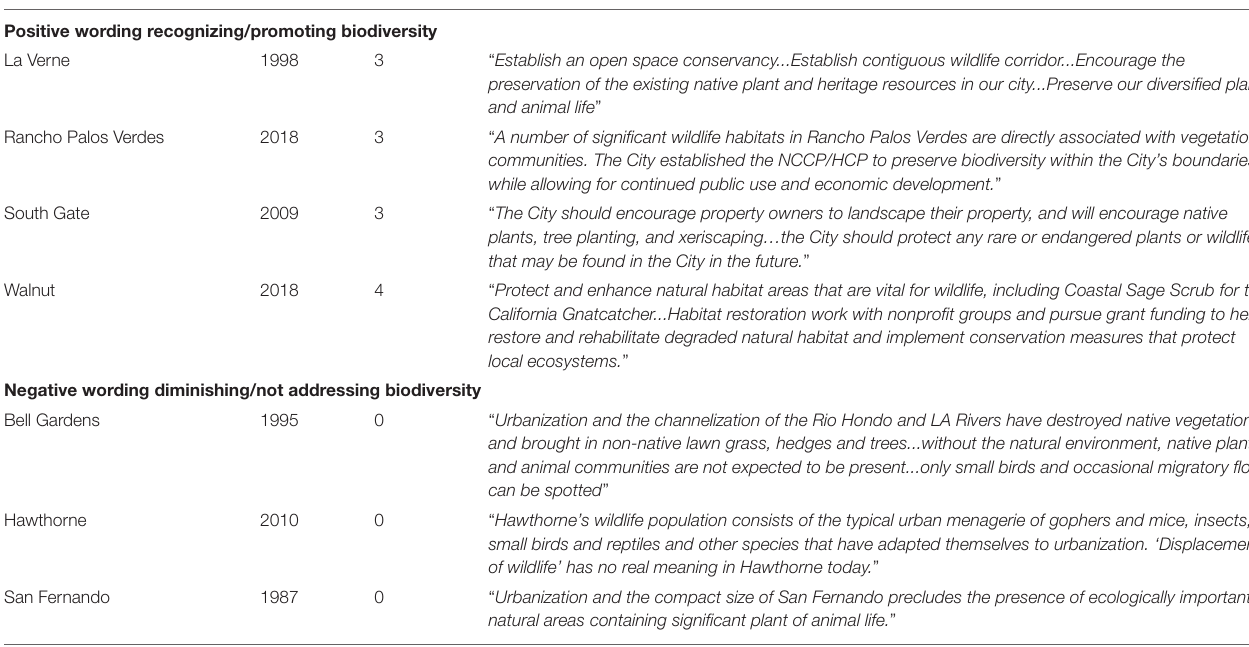
TABLE 1 | Excerpts from General Plans and related elements, Los Angeles County